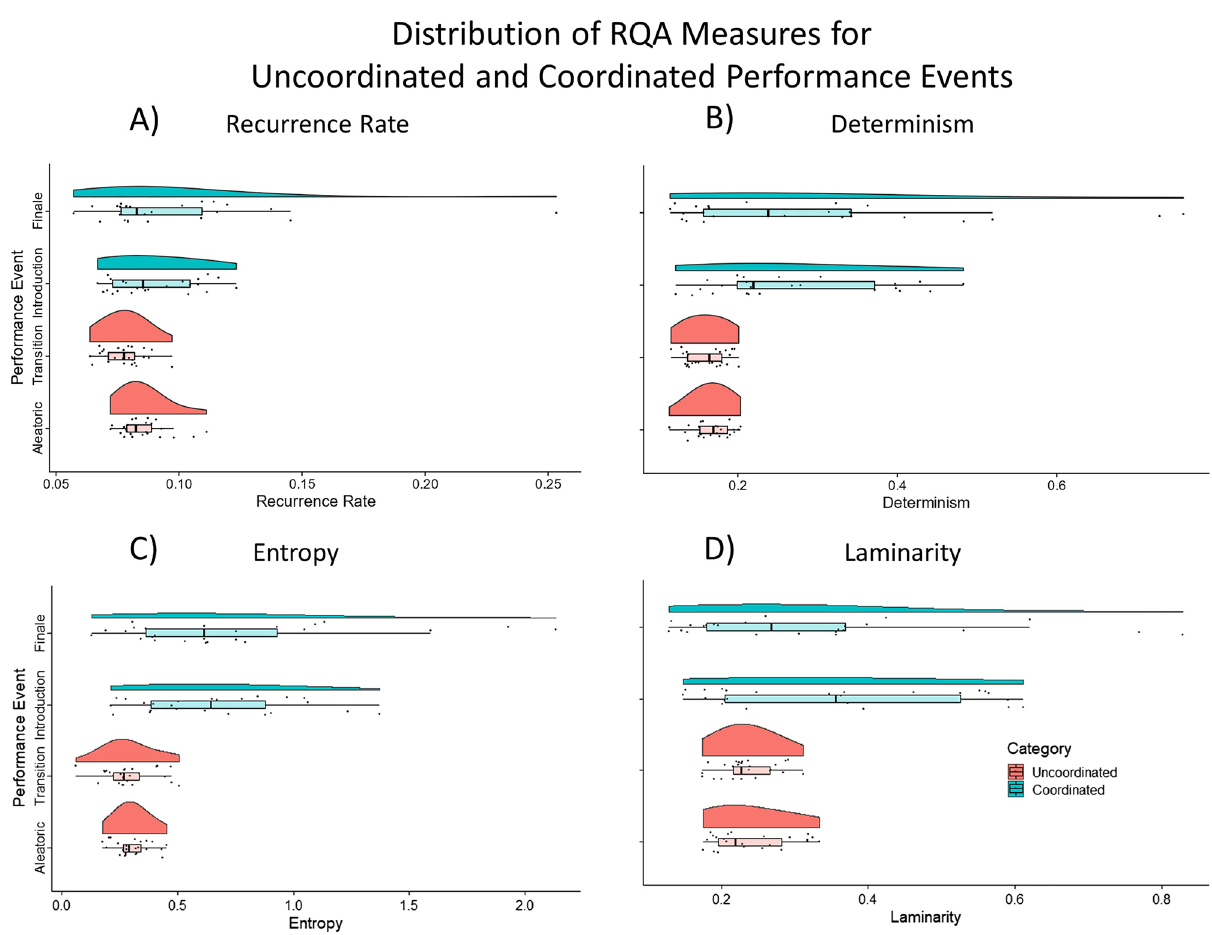
Figure 3. Raincloud plots show higher levels, and wider variance, in each RQA metric in Coordinated compared to Uncoordinated Categories. Boxplots show sample median and interquartile range. Note: 9 s of audience applause during the Introduction Performance Event were not analyzed, and are subsequently excluded from all data